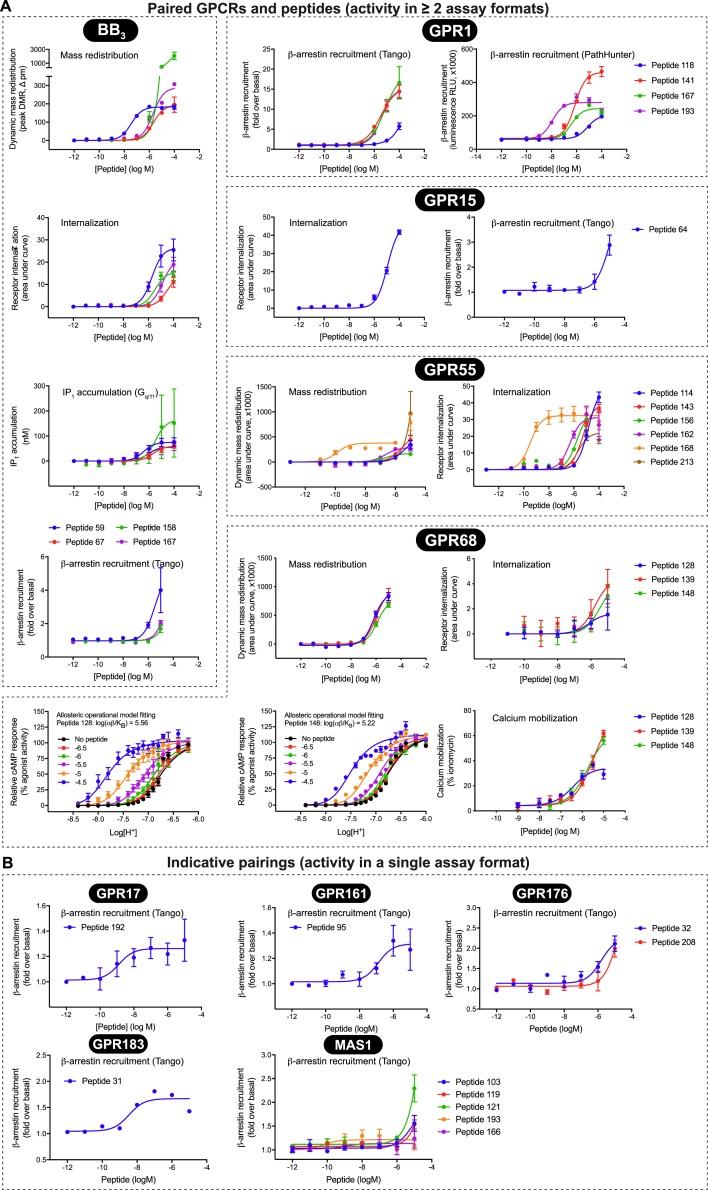
Peptide-GPCR Pairings across Multiple Assay Formats, Related to Figures 4 and 5(A) Concentration-response measurements of BB3, GPR1, GPR15, GPR55 and GPR68 peptide ligands with activity in at least two assays. Assays used were ligand-dependent dynamic mass redistribution, receptor internalization (TR-FRET), Gq/11 (IP1), Gs (GloSensor cAMP) and β-arrestin recruitment (Tango and PathHunter).(B) Indicative pairings from a single assay (Tango) for additional receptor targets. All data represent mean ± SEM for n = 3-4 independent experiments performed in triplicate, except for BB3/peptide 158 in IP1 accumulation (n = 2) and GPR55/peptide 156 (n = 1). Pharmacological parameters are provided in Table S7.